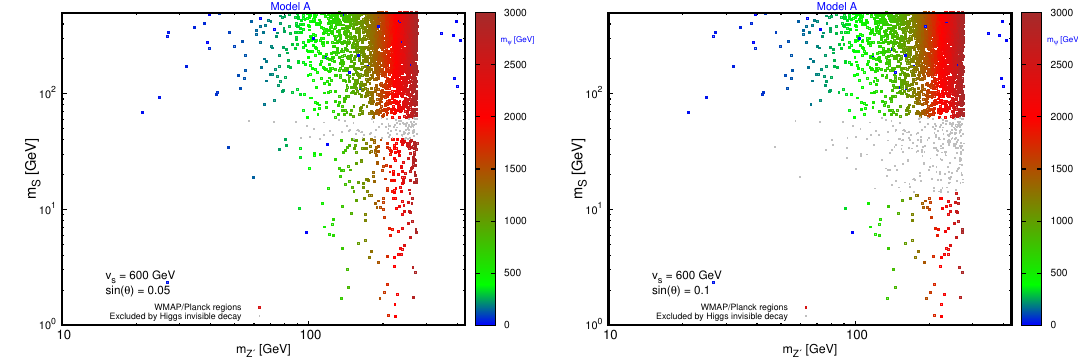
Figure 1 . The plots show the mass of the Z 0 against the mediator mass in model A for two mixing angles left) sin (cid:18) = 0 : 05 and right) sin (cid:18) = 0 : 1. The gray points are excluded by the invisible Higgs decay bound. The scan is done over the parameters with 10 (cid:0) 3 < g 0 < 1, 1 GeV < m s < 500 GeV and 10 GeV < m < 3 TeV. In the scans v s = 600